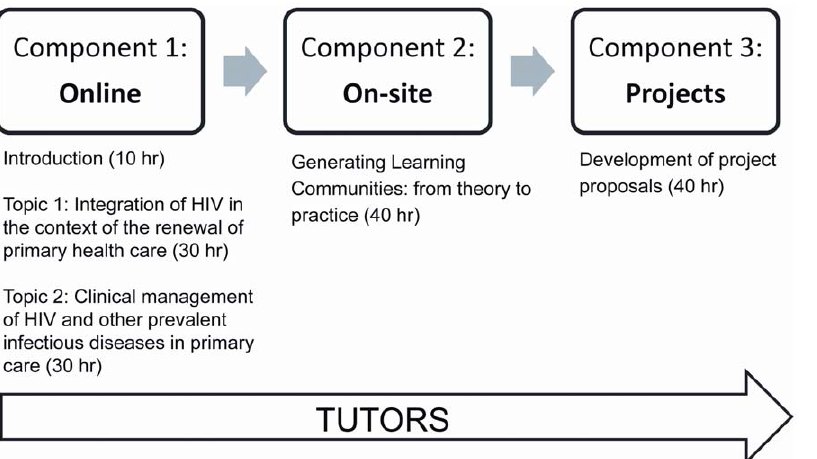
Figure 1. Educational Strategy. The curriculum focused on principles of HIV care and health systems using a tutor-supported blended educational approach of an 8-week online component, a weeklong on-site problem-solving workshop, and individualized project-based interventions.